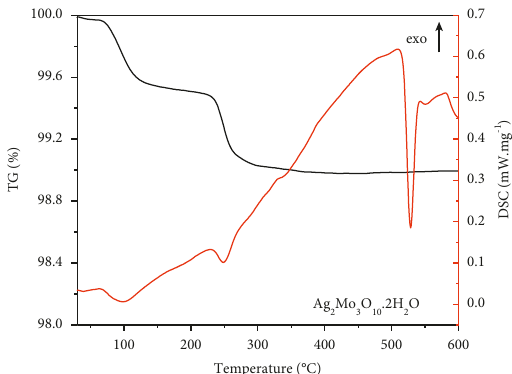
Figure 4: Thermogravimetric (black) and differential scanning 2 Mo 3 O 10 .2H 2 O